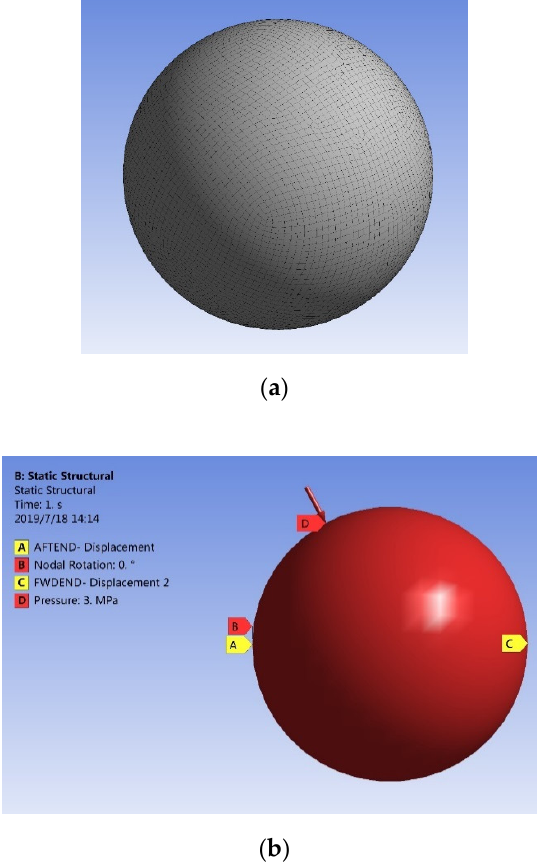
Figure 1. Finite element mesh ( a ) boundary and loading conditions of composite spherical pressure hull ( b ).